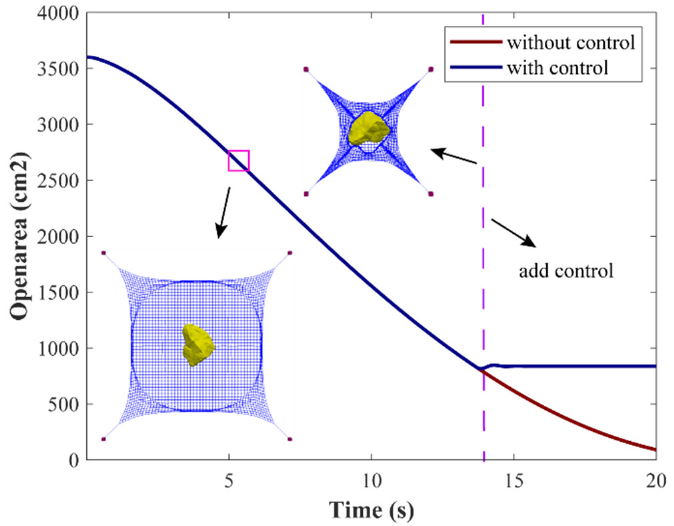
Figure 7. The opening area of the flexible net during the capture and the control process.